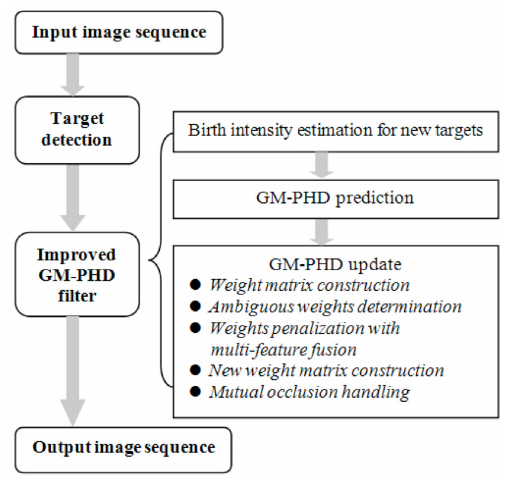
Figure 2. Pipeline of the proposed